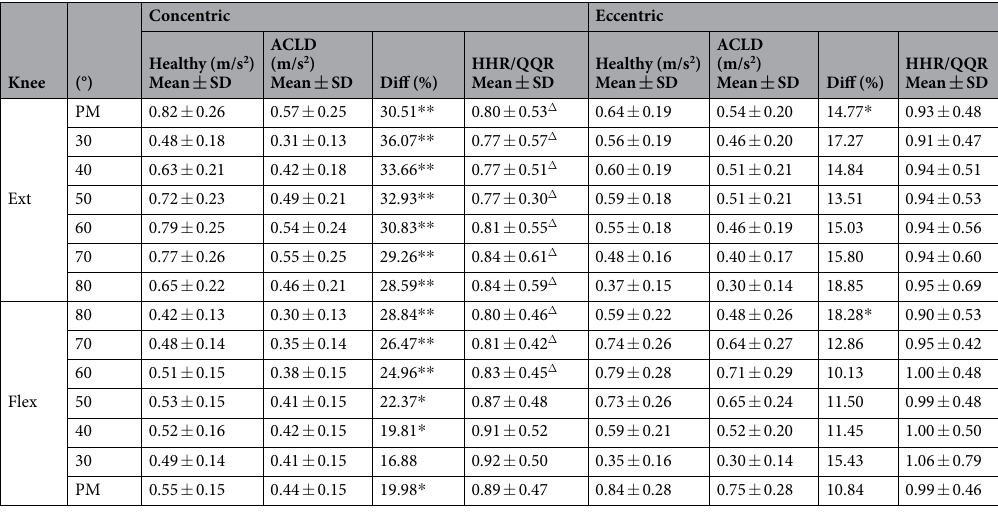
Table 2. Mean normalized moment (m/s 2 ) for knee flexion and extension (N = 46). All the average moments were averaged by the height and weight of each corresponding participant. Single upper asterisk * denotes significant differences at P < 0.05, double upper asterisk ** denotes significant differences at P < 0.01, and single triangle Δ denotes HHR/QQR below 0.85. SD, standard deviation; Ext, knee extension; Flex, knee flexion; ACLD, anterior cruciate ligament deficient side; HHR, ratios of hamstring strength between ACLD side and the healthy side; QQR, ratios of quadriceps strength between ACLD side and the healthy side; Diff, the difference of the average moments between the ACLD side and the healthy